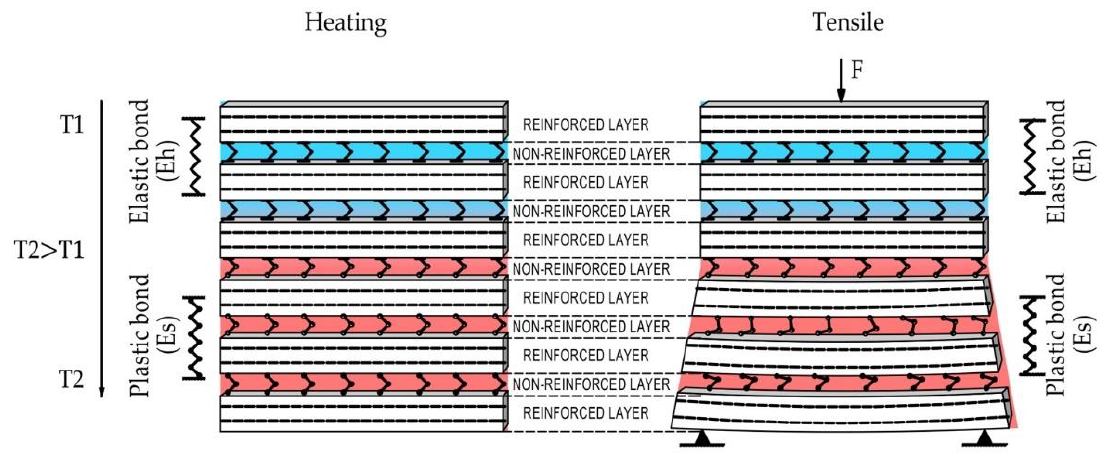
Figure 13. Layer model of deformation of FRP under load when heated.